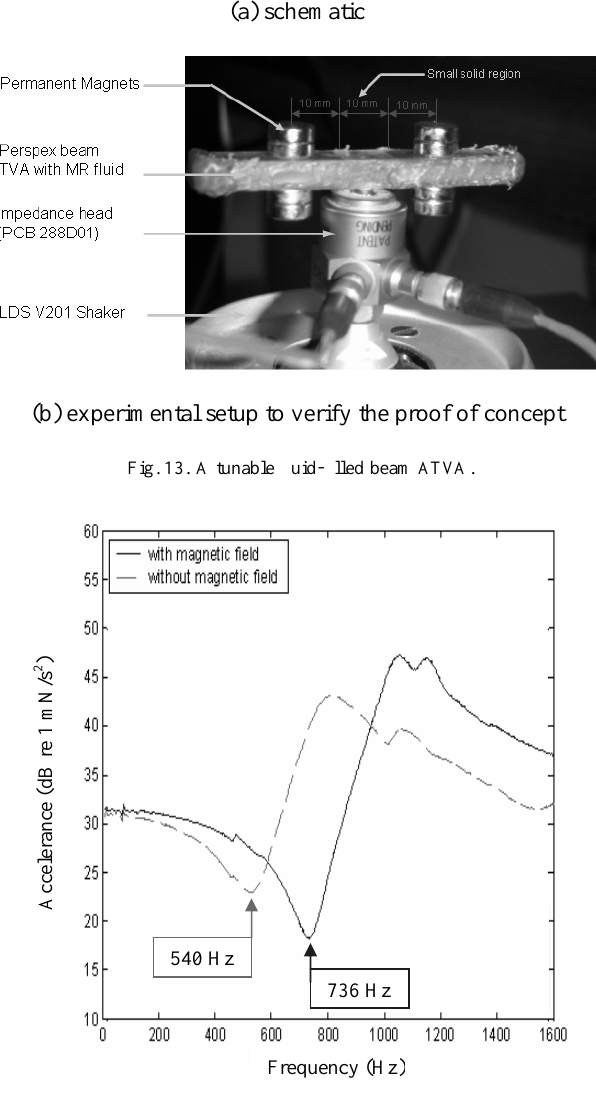
Fig. 14. Measured accelerance of the tunable fluid-filled beam